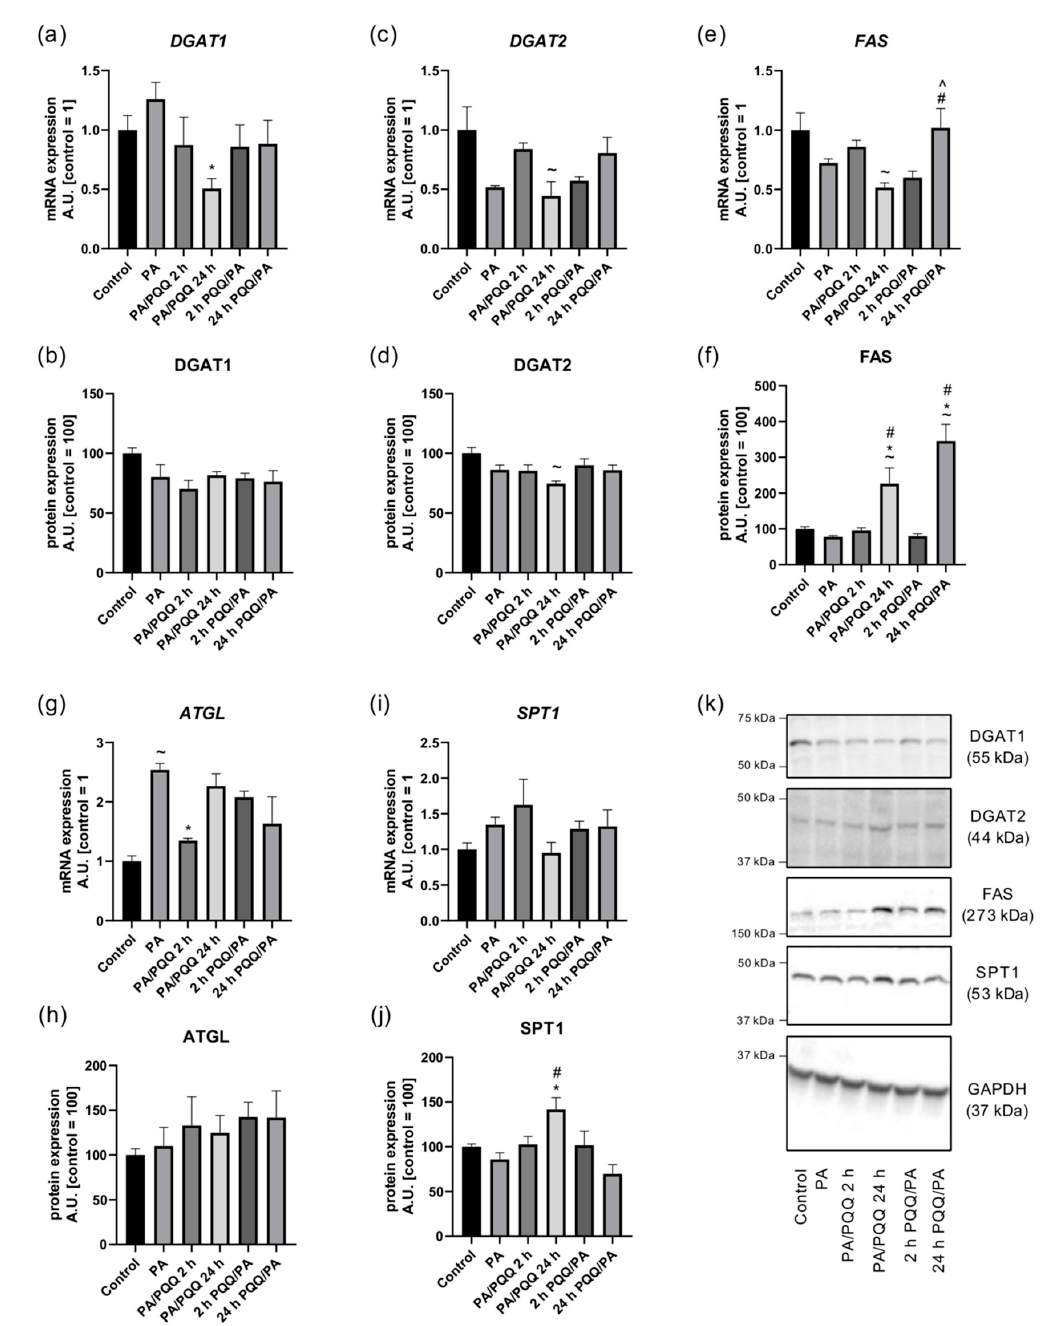
Figure 7. E ff ects of short- and long-time incubation with PQQ on the mRNA and protein levels of ( a , b ) diacylglycerol O-acyltransferase 1, ( c , d ) diacylglycerol O-acyltransferase 2, ( e , f ) fatty acid synthase, ( g , h ) adipose triglyceride lipase, and ( i , j ) serine palmitoyltransferase, long chain base subunit 1 in L6 myotubes. ( k ) Representative Western Blot data. The control is set as 1 (mRNA) or 100 (protein). The values are presented as mean ± SEM and are based on six independent determinations. ANOVA with a post hoc Tukey’s test was applied. ~ p < 0.05, study groups versus control; * p < 0.05, PQQ-incubated groups versus palmitate group; # p < 0.05, time-dependent di ff erences (long- vs. short-time incubation with PQQ); ˆ p < 0.05, sequence-dependent di ff erences (pre-incubation with PQQ vs. post-incubation with PQQ). ANOVA: analysis of variance; GAPDH: glyceraldehyde 3-phosphate dehydrogenase; mRNA: messenger RNA; PA: palmitic acid; PQQ: pyrroloquinoline